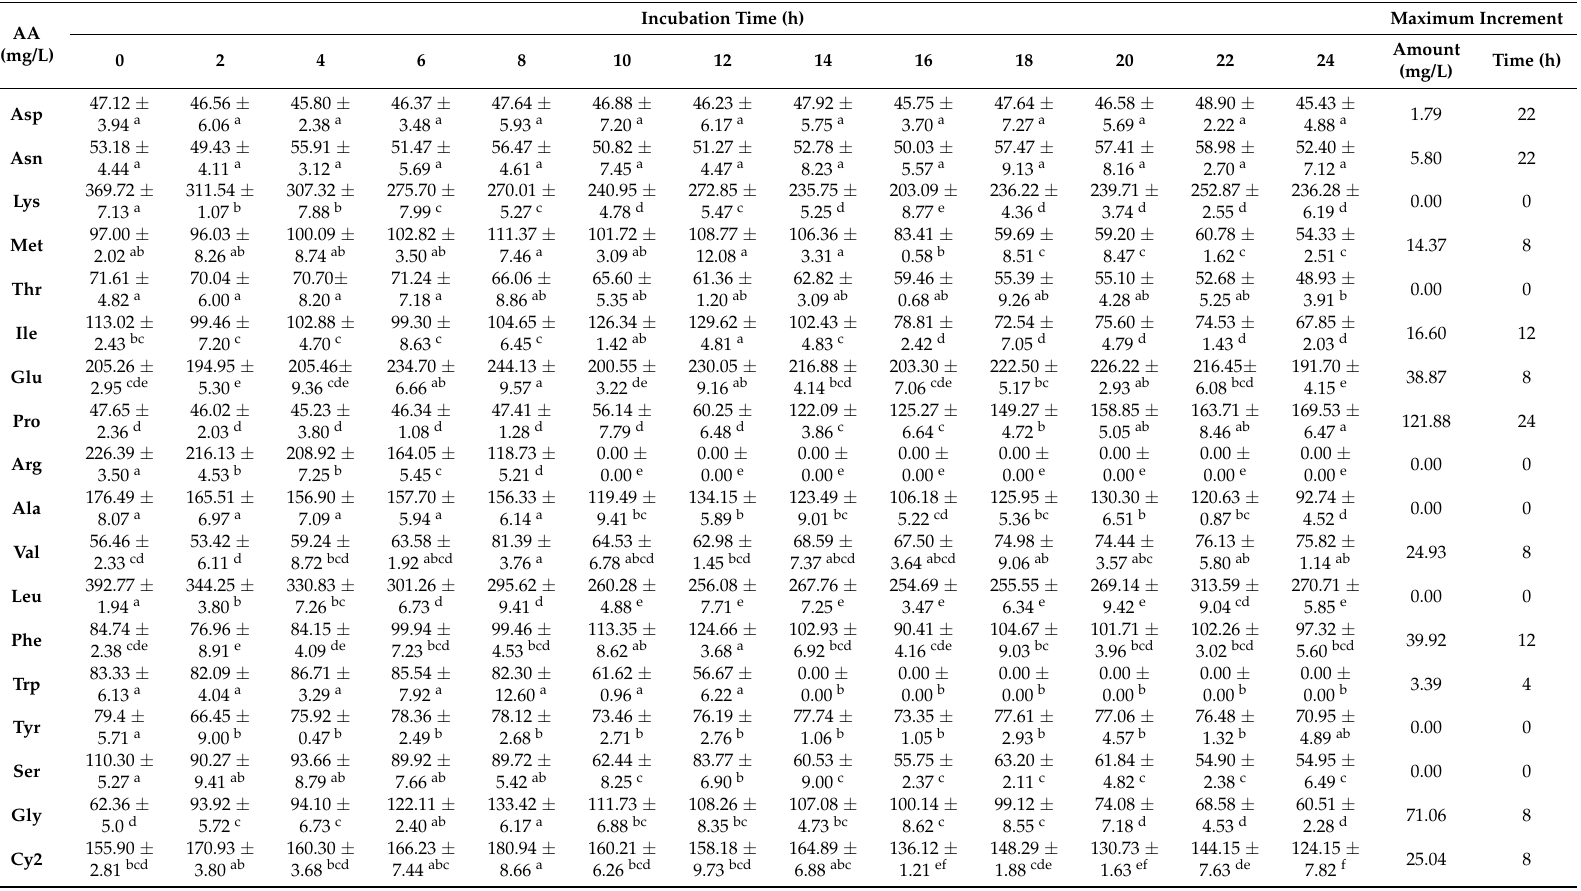
Table 8. The amino acid production profile of P. pentosaceus